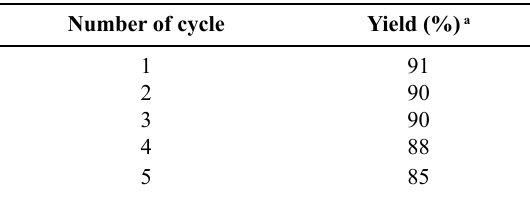
O @SiO -OSO H nanocatalyst 3 4 2 3